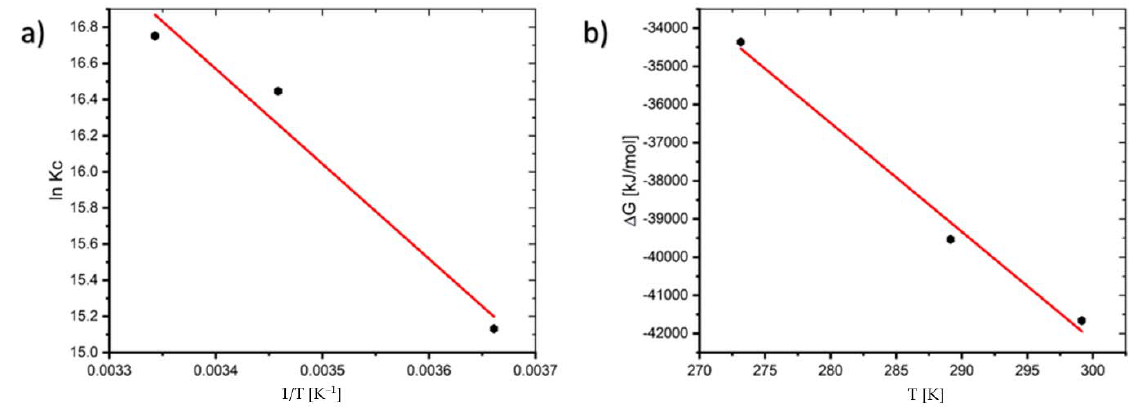
Figure 4. Effect of temperature on adsorption of MB onto coal ( C 0 = 100 mg L − 1 ; mass of coal = 0.1 g; volume of MB solution = 25 mL; pH = 6.35).